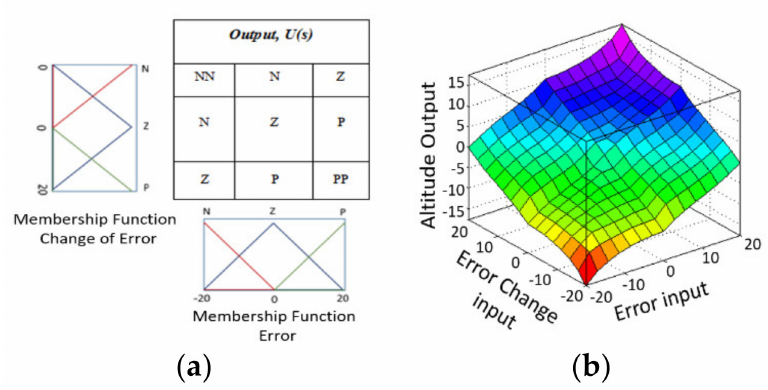
Figure 7. ( a ) Fuzzy outputs identification, ( b ) Mamdani Fuzzy–PD control